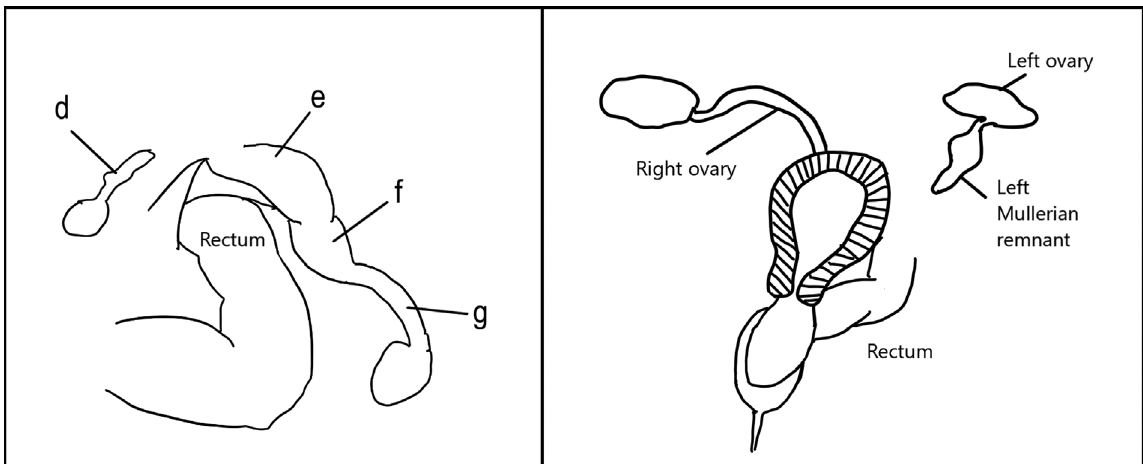
Fig. 2 Left Image. A schematic drawing of ► Fig. 1 , with the perspective of looking into the pelvis from a cephalad (bottom border) to caudal (top border) perspective. Right Image . Inverted diagram showing cephalad (top border) to caudal (bottom border) orientation. d. Left atretic Mullerian system. e. Right obstructed vagina. f. Right patent uterus. g. Right patent fallopian